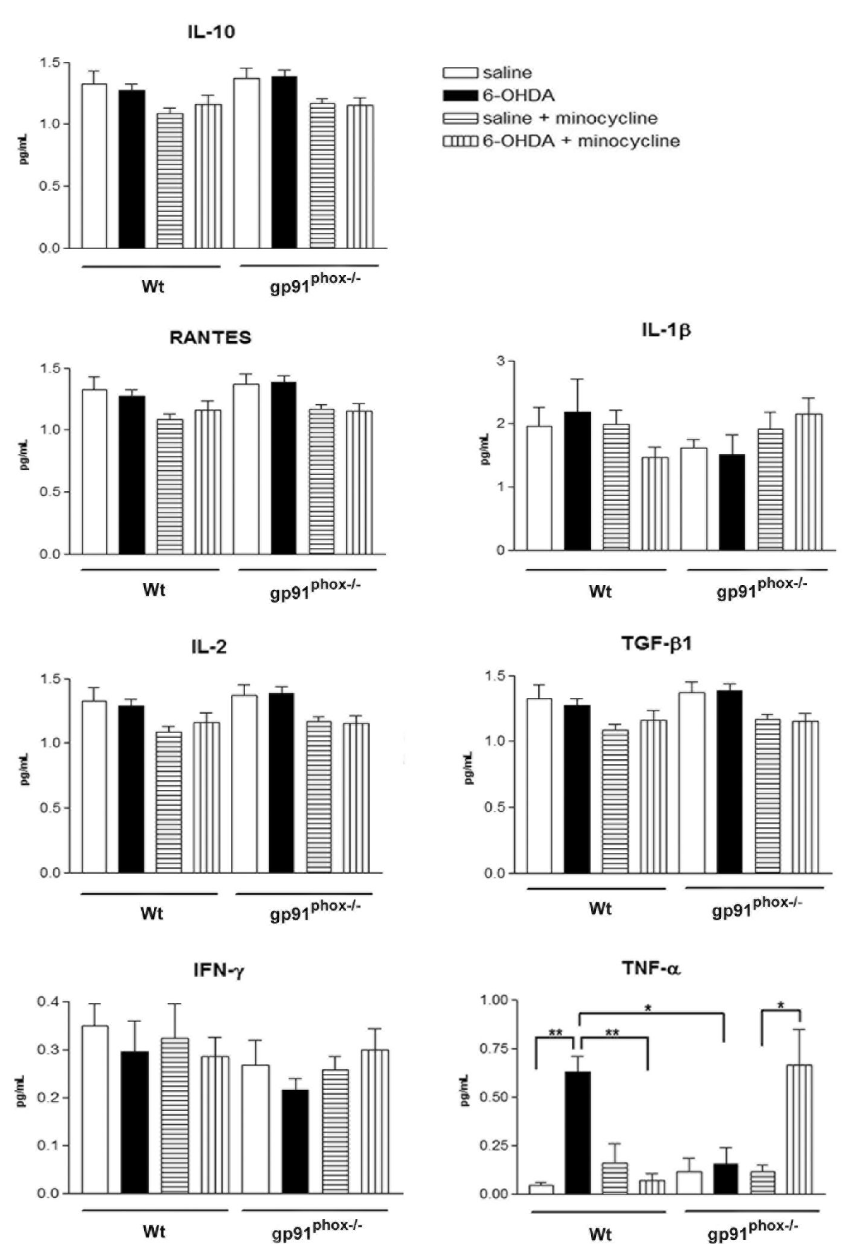
Figure 5. Effect of minocycline treatment on substantia nigra cytokine concentration in Wt and gp91 phox-/- 6-OHDA-lesioned mice. Concentration of pro-inflammatory (IL-1β, TNF-α, IFN-γ, IL-2) and anti-inflammatory cytokines (IL-10 and TGF-β1) and the chemokine RANTES in the substantia nigra following 6-OHDA-induced PD in Wt and gp91 phox-/- treated with minocycline or PBS. All concentrations were expressed in pg/ml. The statistical significance is expressed as: * P<0.05; ** P<0.01 and *** P<0.001; n=6 for each experimental group tested. doi: 10.1371/journal.pone.0075532.g005 inflammatory cytokine, and NF-κB activation has been Continuous production of this cytokine induced by an previously demonstrated as an important molecular event adenoviral vector leads to chronic microglia and macrophage occurring in the 6-OHDA-induced neurodegeneration [43,44]. activation in the SN, progressive neurodegeneration, and TNF-α release has been identified as a critical mechanism delayed motor symptoms [45]. Among all the cytokines involved in DA neuroinflammation and in neuron damage. evaluated in the present study, we observed that microglial cell